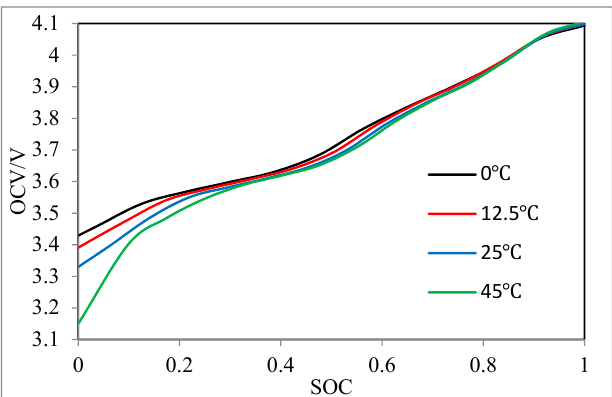
Figure 5. SOC-OCV at different temperatures.